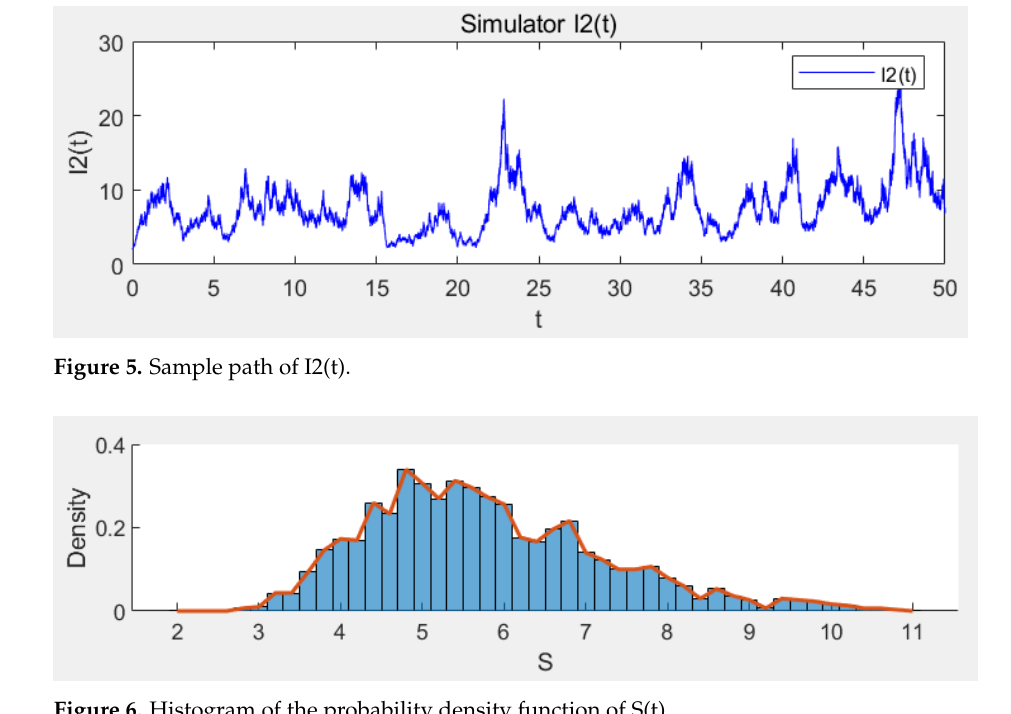
Figure 6. Histogram of the probability density function of S(t).